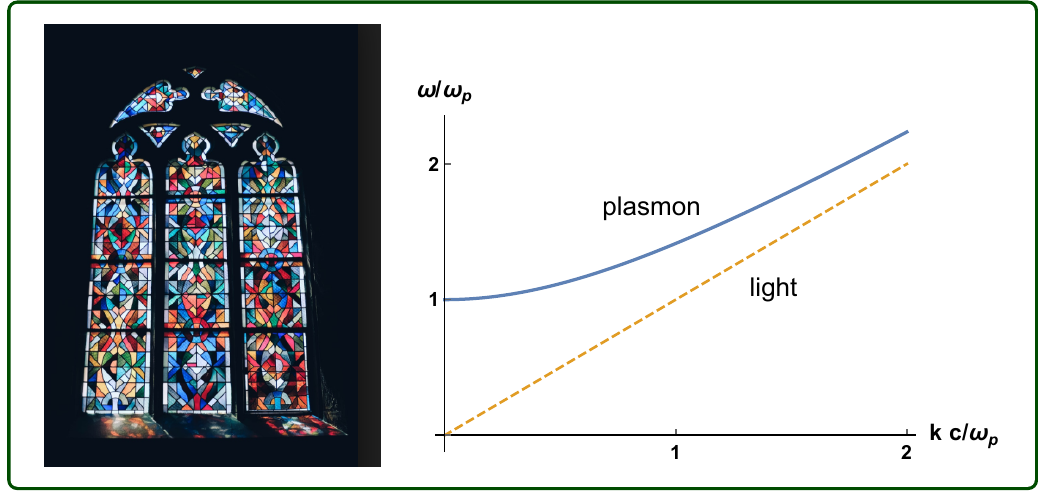
Figure 1 . Left: one example of the applications of plasmons in art in the form of a stained glass window in Notre Dame, Paris. Right: the typical bulk plasmon dispersion relation ! 2 = ! 2 compared with the photon dispersion relation in